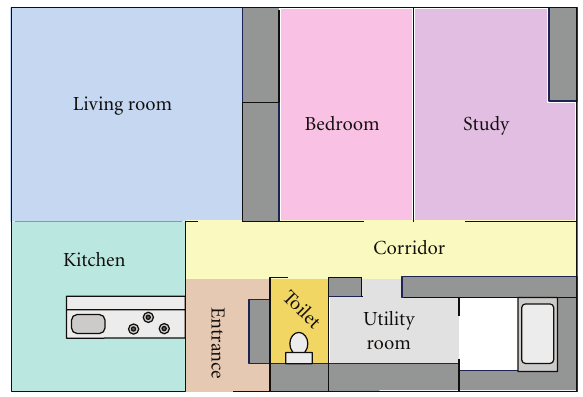
Figure 1: Partitioning the smart home floor into